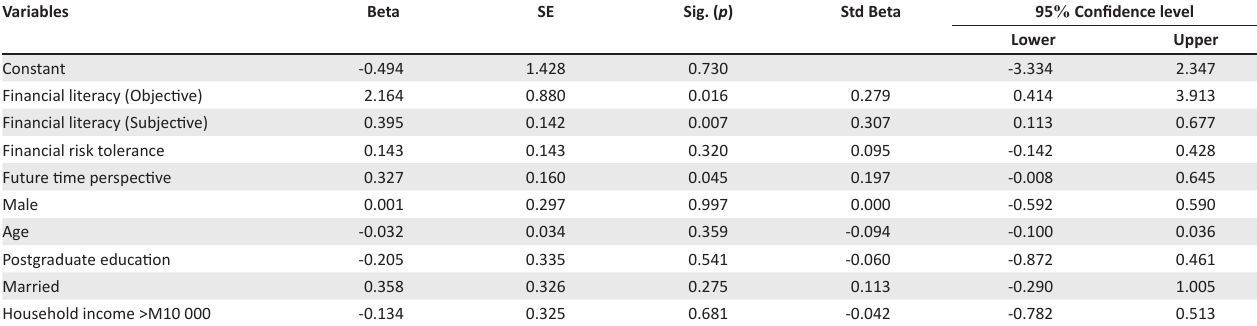
TABLE 5: Linear model for predictors – Non-banking employees.